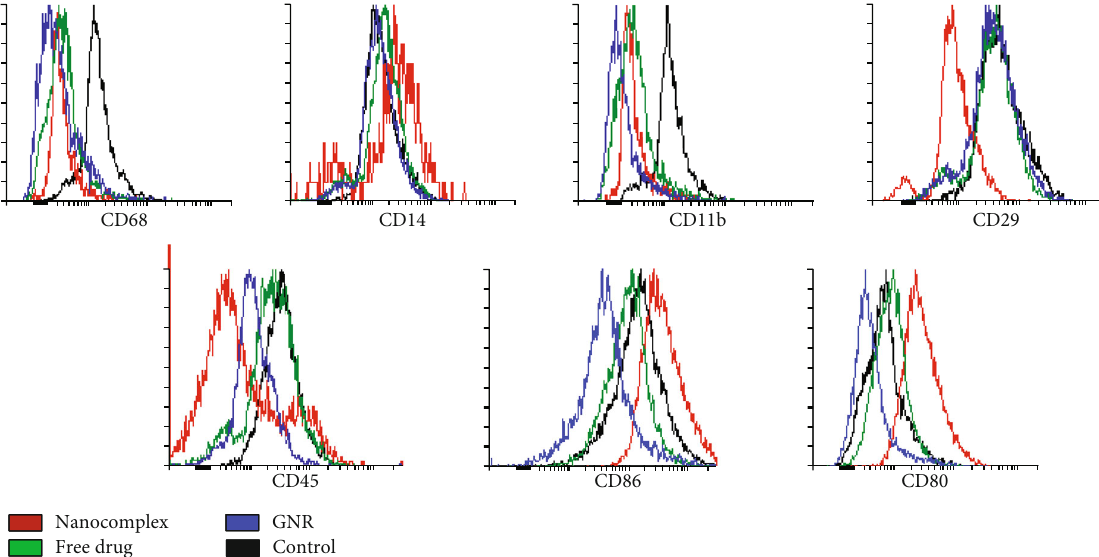
Figure 2: Flow cytometric histograms of PMA+LPS-macrophages surface expression markers after treatment with: nanocomplex (a drug- conjugated gold nanorods), the free drug (phosphatidylinositol 3-kinase (PI3K α ) inhibitor), and GNR; cholesterol-coated gold nanorods for 24hrs, compared to the control untreated